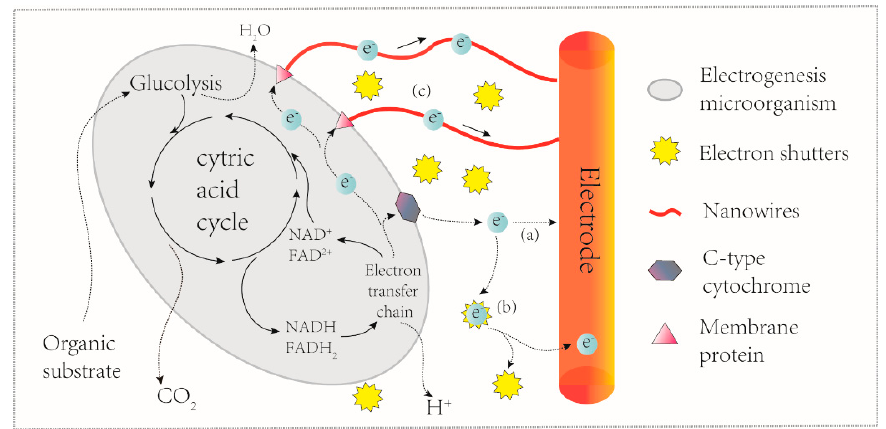
Figure 2. A schematic representation of three microbial extracellular electron transfer mechanisms at anode electrode of MFCs. ( a ) direct transfer via contact and c-type cytochromes; ( b ) indirect electron transfer by electron shuttles; ( c ) direct electron transfer by conductive nanowires.